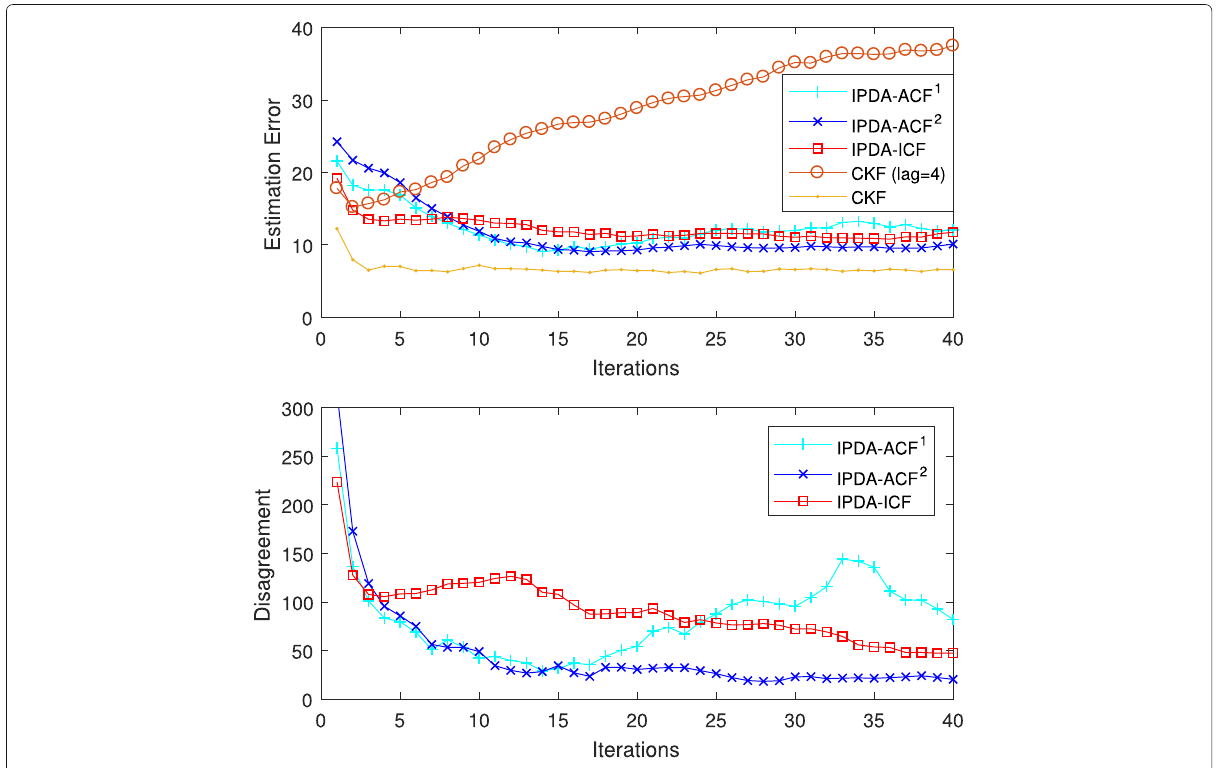
Fig. 5 Performance of the algorithms: clutter is present